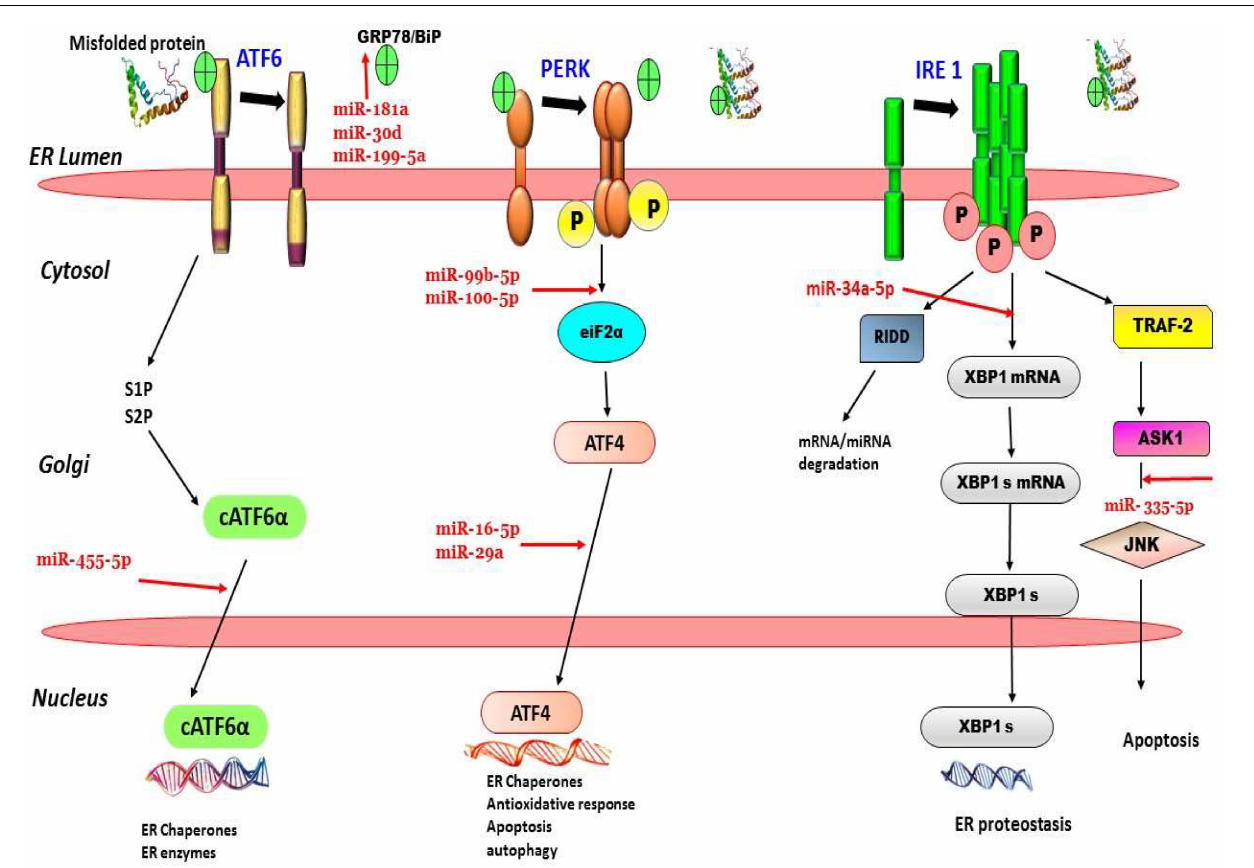
FIGURE 2 | ER stress, UPR, and microRNA relation in Alzheimer’s disease. For instance, evidence suggests that, miR-199-5a, miR-30a and miR-181 suppress GRP78 expression. miR-34a-5p downregulates XBP-1 expression in. miR-335 is involved in activation of JNK pathway leading to apoptosis, etc., can be seen in the